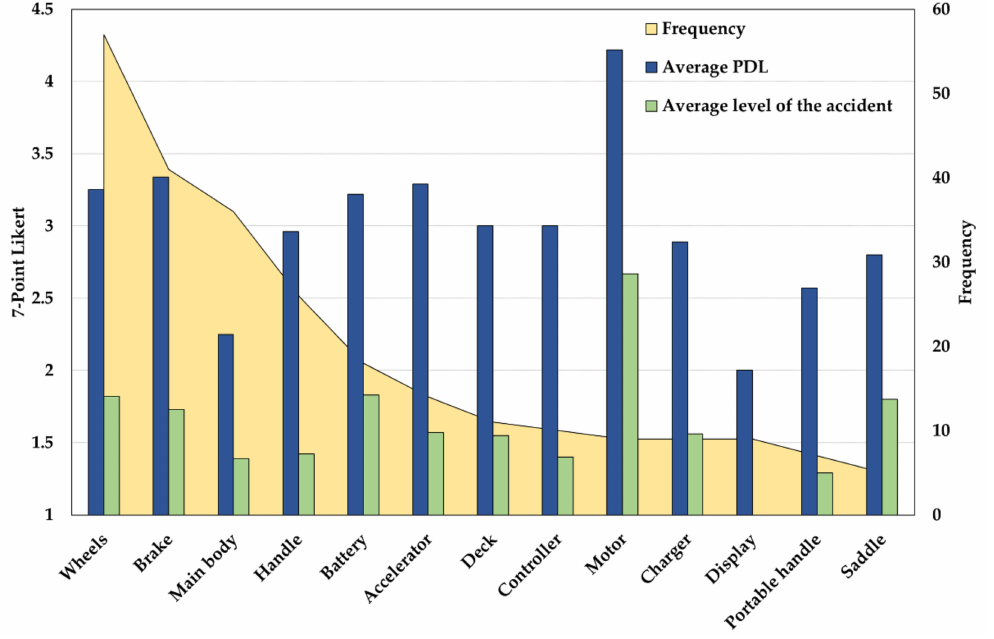
Figure 4. Episode distributions and average scores relying on the “product factor”.